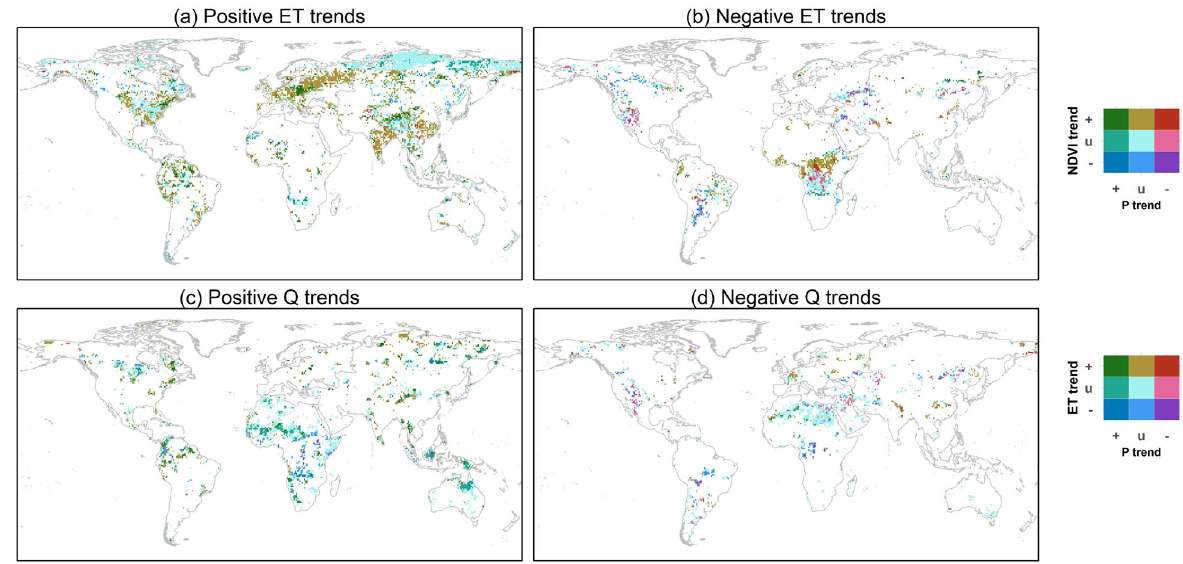
Fig. 4 Spatial analysis of simultaneous change in trends of P , ET, Q and NDVI. Spatial distribution of positive ( + ), negative ( − ) and uncertain (u) trends in P and NDVI coincident with positive ET trends ( a ) and negative ET trends ( b ). Spatial distribution of positive, negative and uncertain trends in P and ET coincident with positive Q trends ( c ) and negative Q trends ( d ). Uncertain trends include uncertain positive, uncertain negative and disagreeing